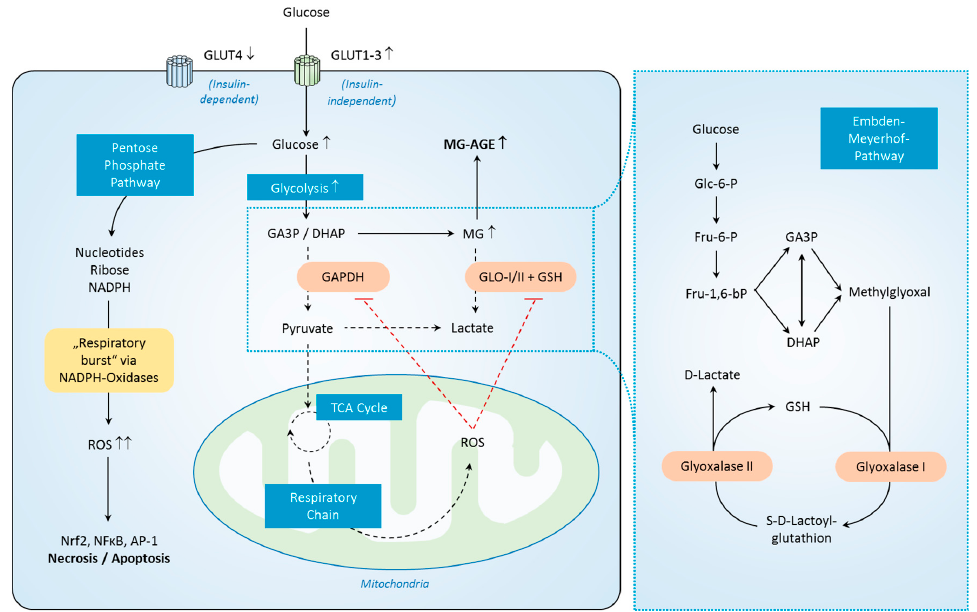
Figure 2. Regulation of MG-derived carbonyl stress in sepsis. Aside from enhanced glycolysis, increased formation of ROS with subsequent inhibition of GAPDH and the glyoxalase system in addition to glutathione consumption contributes to MG-derived carbonyl stress in sepsis. Small upward arrows symbolize increased levels. While solid arrows indicate pathway sequences, dashed arrows indicate reduced steps of a pathway. Abbreviations: GLUT = glucose transporter, MG = Methylglyoxal, MG-AGE = MG derived advanced glycation educts, GA3P = Glyceraldehyde 3- phosphate, DHAP = Dihydroxyacetone phosphate, GAPDH = Glyceraldehyde 3-phosphate dehydrogenase, GLO = Glyoxalase, GSH = Glutathion, TCA = tricarboxylic acid, ROS = reactive oxygen species, NADPH = Nicotinamide adenine dinucleotide phosphate, Nrf2 = Nuclear factor 2, NF κ B = Nuclear factor κ B, AP-1 = Activator protein 1, Glo-6-P = Glucose-6-Phosphate, Fru-6-P = Fructose-6-Phosphate, Fru-1,6-bP = Fructose-1,6-Bisphosphate. First of all, systemic inflammation is characterized by massive amounts of ROS, which need to be detoxified. However, a wide range of antioxidant mechanisms rely on glutathione as a co-substrate [142]. The resulting increased glutathione consumption consecutively impairs the glyoxalase system. Secondly, the ROS “hyperoxide” is known to directly inhibit GLO-1 [143]. Consistent with this, we previously found significantly increased levels of both ROS and RCS in critically ill patients